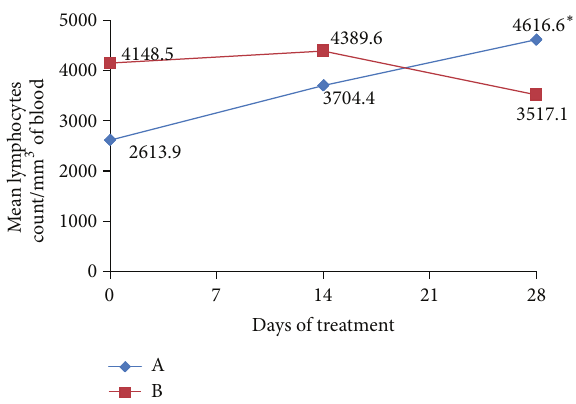
Figure6:Meanvaluesoflymphocytescountintheperipheralblood of animal groups assessed. ∗ significant difference within the group ( 𝑃 < 0.05 ). Reference values: 800–4160 cells/mm 3 of